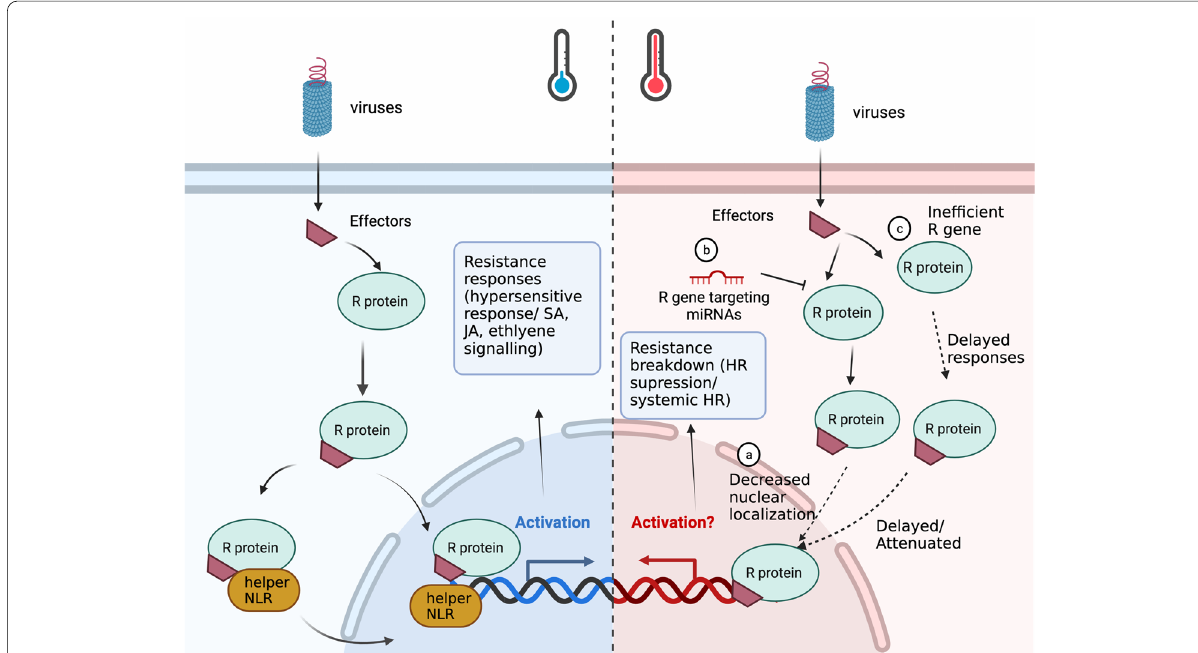
Fig. 2 Schematic representation of plant antiviral resistance pathways (left) and resistance‑breaking pathways (right). Activation of plant resistance responses is triggered by the recognition of viral effectors and plant resistance (R) proteins. For the resistance response, activated R proteins, belonging to nucleotide‑binding leucine‑rich repeat (NLR) type, may translocate to the nucleus or pair with helper NLRs to trigger downstream responses, such as hypersensitive response (HR), salicylic acid (SA), jasmonic acid (JA), and ethylene signalling (left). Under elevated temperature condition, a suppression or delay of resistance responses may be caused by a decreased nuclear localization of R proteins, b miRNA‑mediated R gene degradation, or c insufficient R proteins, leading to resistance‑breaking phenotypes, including HR suppression and systemic